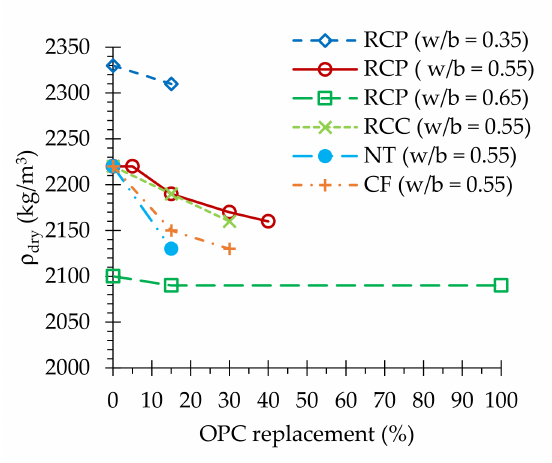
Figure 7. Dry density, ρ dry , of concrete with different incorporation percentages of additions.